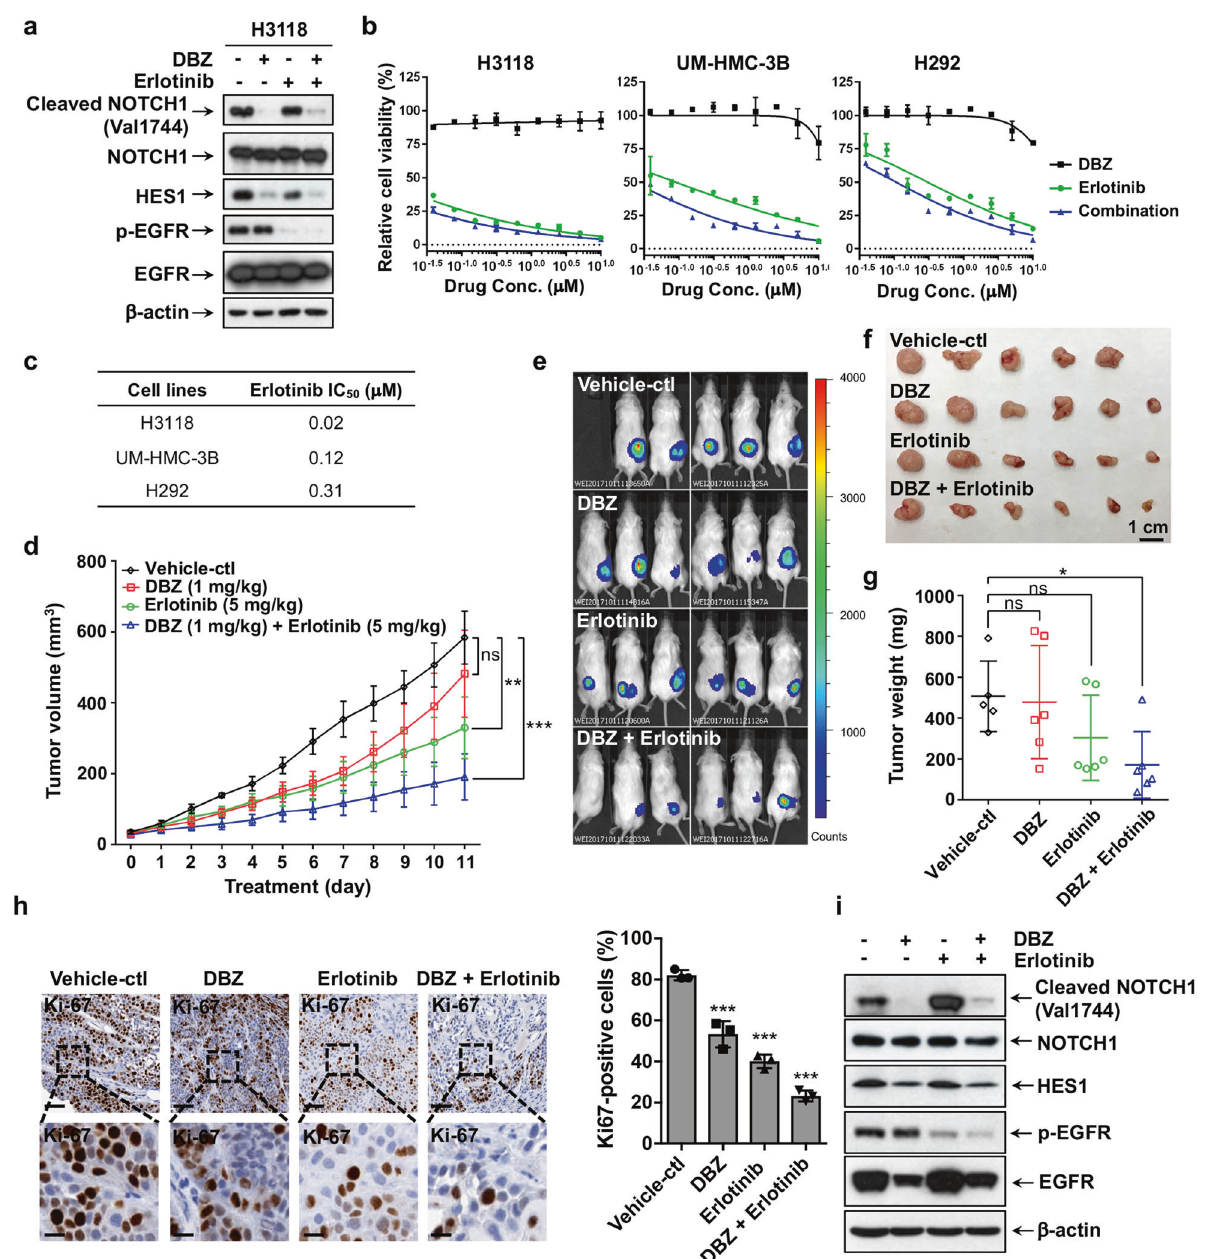
Fig. 6 Co-inhibition of Notch and EGFR signaling synergistically inhibited the growth of MEC xenografts. a H3118 cells were treated with either DBZ (1 μ M), Erlotinib (1 μ M), or in combination for 24 h, and the treated cells were analyzed for Notch and EGFR signaling status by Western blot analysis using the antibodies as indicated. b Cell viability assays were performed on human MEC cells treated with various concentrations of DBZ, Erlotinib or in combination for 72 h. c The IC 50 values of Erlotinib were shown. The IC 50 of DBZ was not applicable as no inhibitory effect was observed. d – g NOD.SCID mice were subcutaneously inoculated with luciferase-expressing H3118 MEC cells. When the xenografts grew to ~50 mm 3 , mice were treated with vehicle control ( n = 5), 1 mg/kg DBZ ( n = 6), 5 mg/kg Erlotinib ( n = 6), or 1 mg/kg DBZ plus 5 mg/kg Erlotinib ( n = 6) via IP injection (DBZ) or oral gavage (Erlotinib) daily for 11 days. The tumor volumes were measured daily after treatment ( d ). Bioluminescent imaging of the xenograft tumors ( e ), tumor size ( f ), and tumor weight ( g ) were presented on the fi nal day of treatment. h Representatives of Ki-67 staining of H3118-luc xenografts from each treatment group were shown (upper bar = 100 μ m, lower bar = 25 μ m). ImageJ was used to calculate Ki-67-positive cells in IHC staining results and sections of individual tumors ( n = 3) in each group were analyzed. i Western blotting was performed to determine the levels of cleaved and total NOTCH1, HES1 as well as the phosphorylated and total EGFR post-drug treatments. The mice were given a boost administration of DBZ (5 mg/kg) and Erlotinib (25 mg/kg) either alone or in combination 2 h prior to euthanasia (* p < 0.05; ** p < 0.01; *** p < HES1 protein and that Erlotinib lowered the EGFR phosphorylation (1 mg/kg) plus Erlotinib (5 mg/kg) caused the greatest reduction in level in H3118 xenografts (Fig. 6i), suggesting that tumor the proliferating tumor cells in xenograft tumors as shown by Ki- suppression was caused by on-target effects of each drug. These 67 staining (Fig. 6h). Western blotting con fi rmed that DBZ reduced data indicate that the combination of the Notch inhibitor DBZ and the levels of the active NOTCH1 (cleaved NOTCH1) and its target